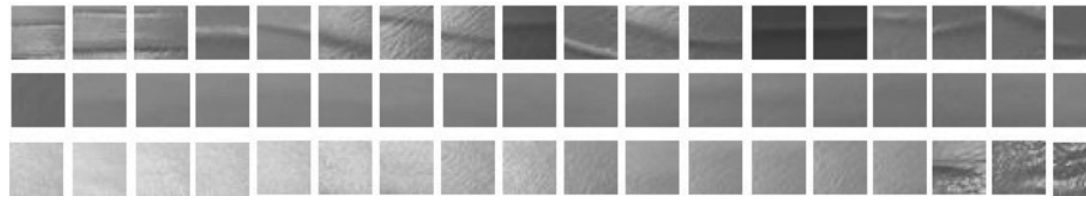
Figure 9: Image patches after binarization processing. First row represents positive samples, second row represents the nega- tive samples and third row represents the